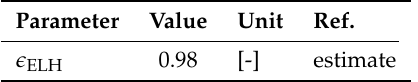
Table A2. Parameter data